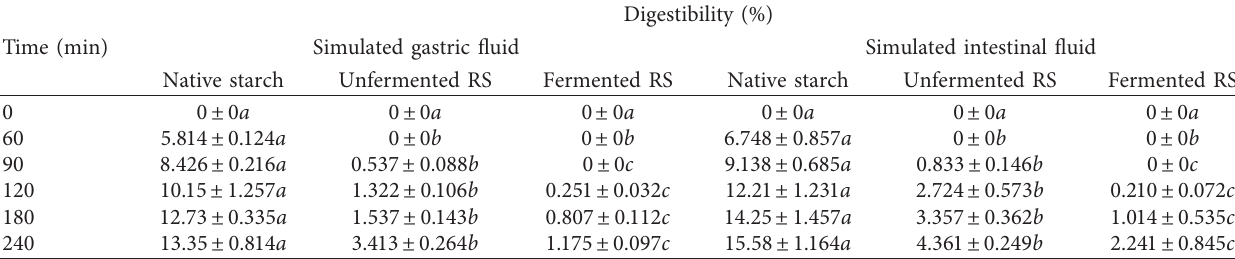
Table 2: Determination of in vitro digestibility of fermented sorghum-resistant